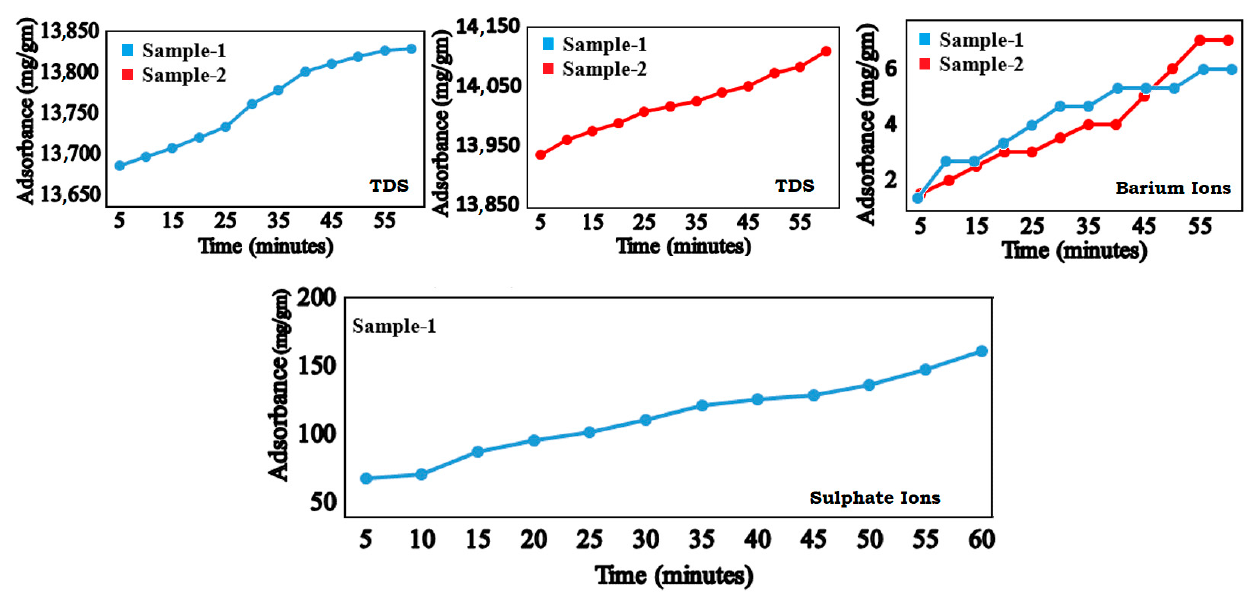
Figure 8. Adsorption concentration (mg/gm) of TDS, barium and sulfate ions in sample 1 and 2 at different time intervals.